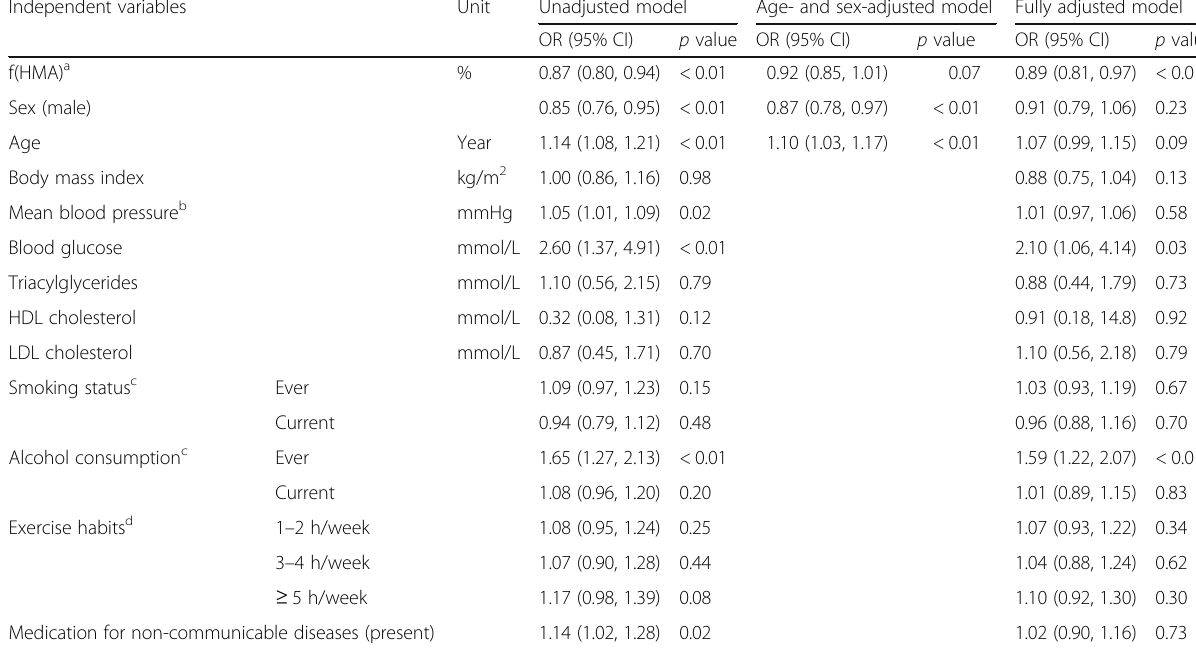
Table 3 Logistic regression analysis for the association between selected variables and plaque formation Independent